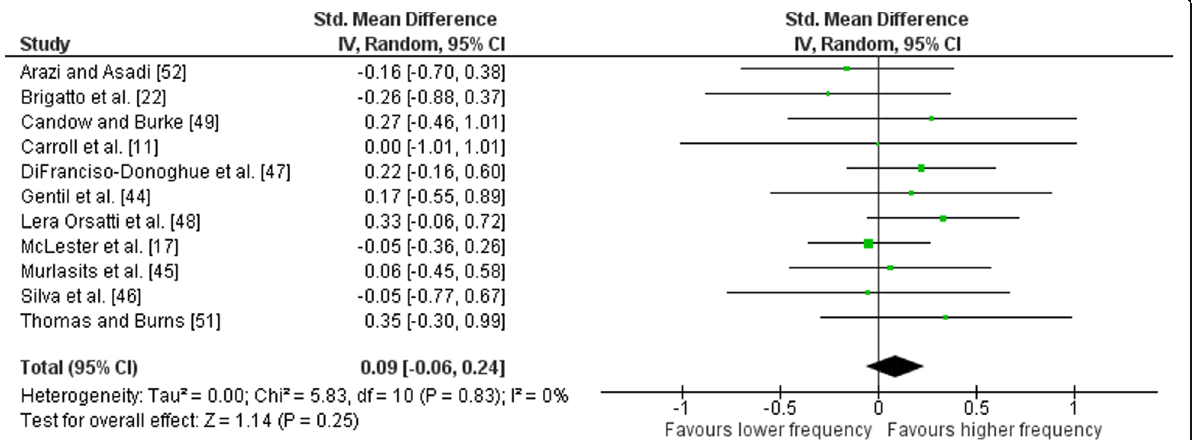
Fig. 4 Lower vs. higher weekly training frequency. Pre- vs. post-mean ES strength difference on multi-joint and isolation exercise. The vertical line indicates the overall estimate of combined multi-joint and isolation studies pre- vs. post-mean ES strength difference. Horizontal lines indicate